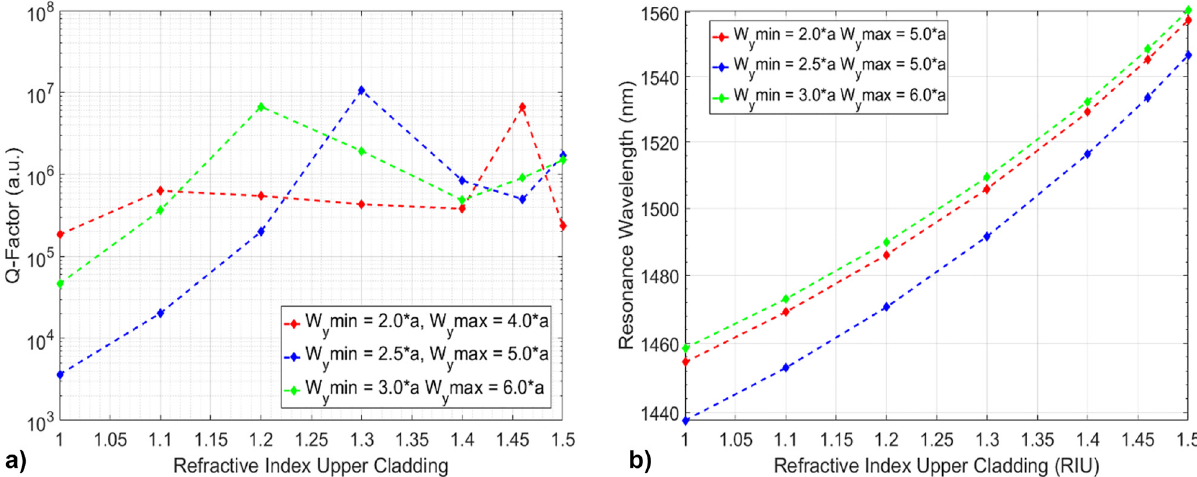
Figure 2: PhC cavity design, (a) Calculated Q-factors with varying upper-cladding refractive index. Each Q-factor curve represents a different quadratic tapering function, which is defined by width of the central and last SiN sticks, W resonant wavelength with varying upper-cladding refractive index in the different tapering configurations.